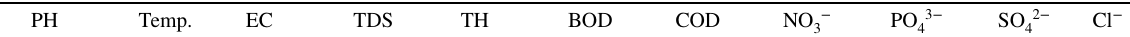
Table 9 Pearson’s correlation matrix of analyzed variables for water samples